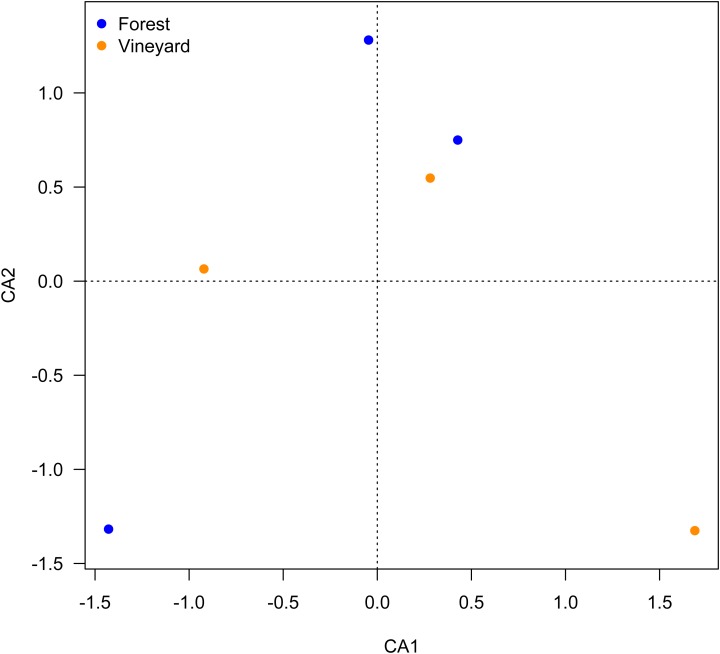
Ordination plot for microbial composition in soils.Ordination plot from the canonical correspondence analysis (CCA) based on the abundance of OTUs found the microbial communities found in forest and vineyard soils.